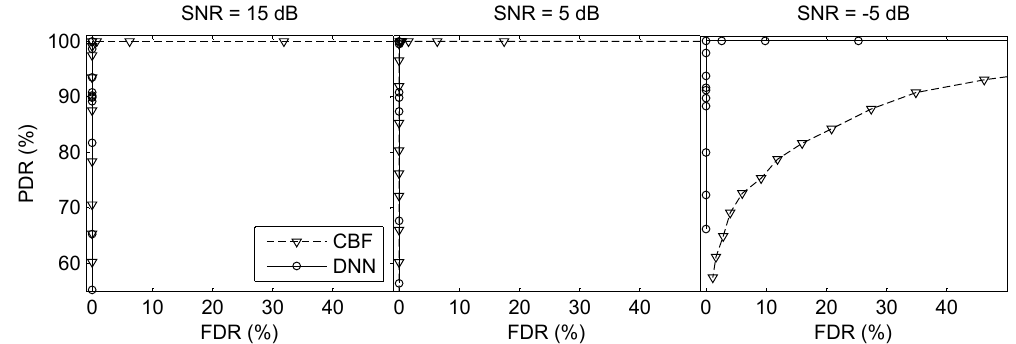
Figure 9. ROC curves of direction finding on HCA under different SNRs in the two-source